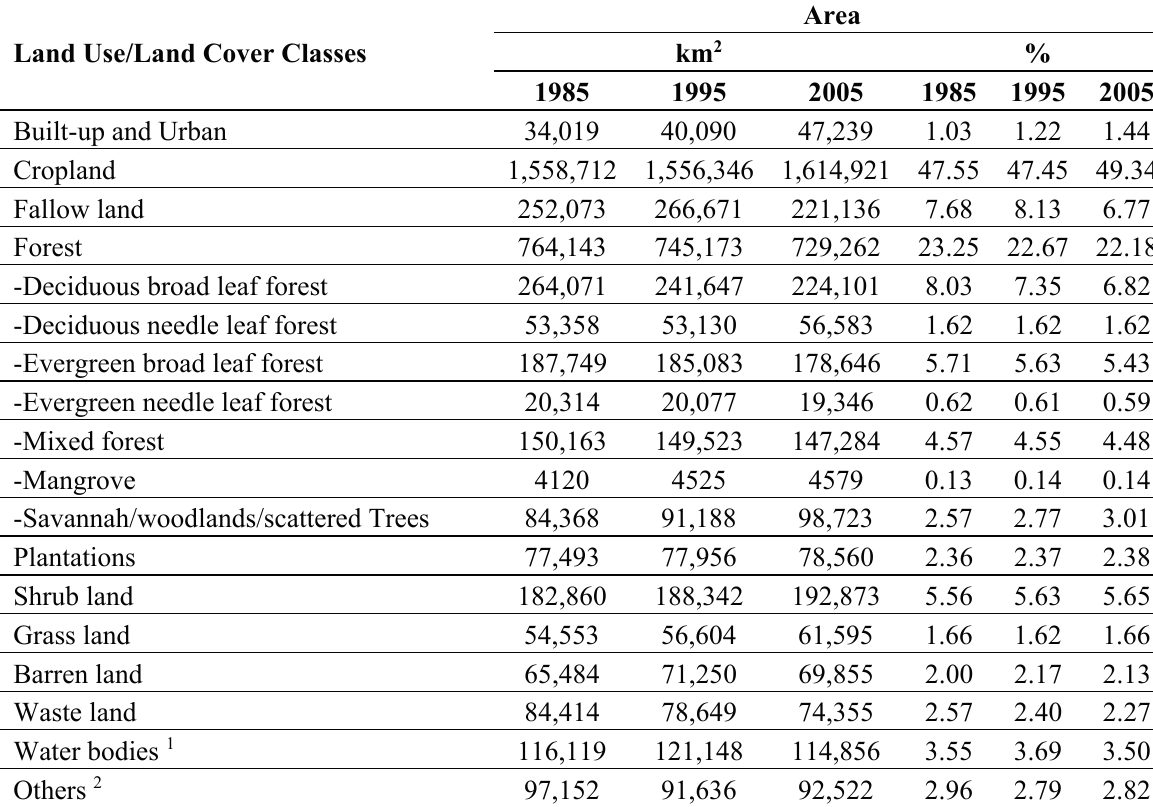
Table 2. Overall extent of land use and land cover classes in